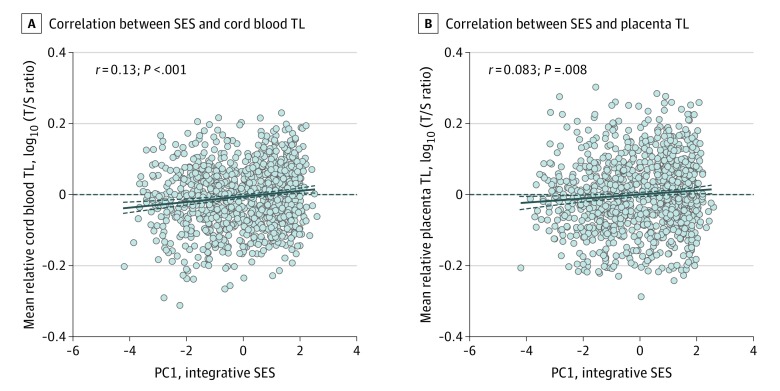
Scatterplot Depicting the Association Between Integrative Socioeconomic Status (SES) Measure and Newborn Telomere Length (TL)A, Unadjusted Pearson correlation between SES and mean relative cord blood TL (n = 1026). B, Unadjusted Pearson correlation between SES and average relative placenta TL (n = 1026). PC1 indicates principal component 1 as a reflector of the integrative SES measure; T/S, telomere copy number to single-copy gene number. The thick dark blue solid line is the regression line, and the dark blue dashed lines above and below it indicate the 95% CI.